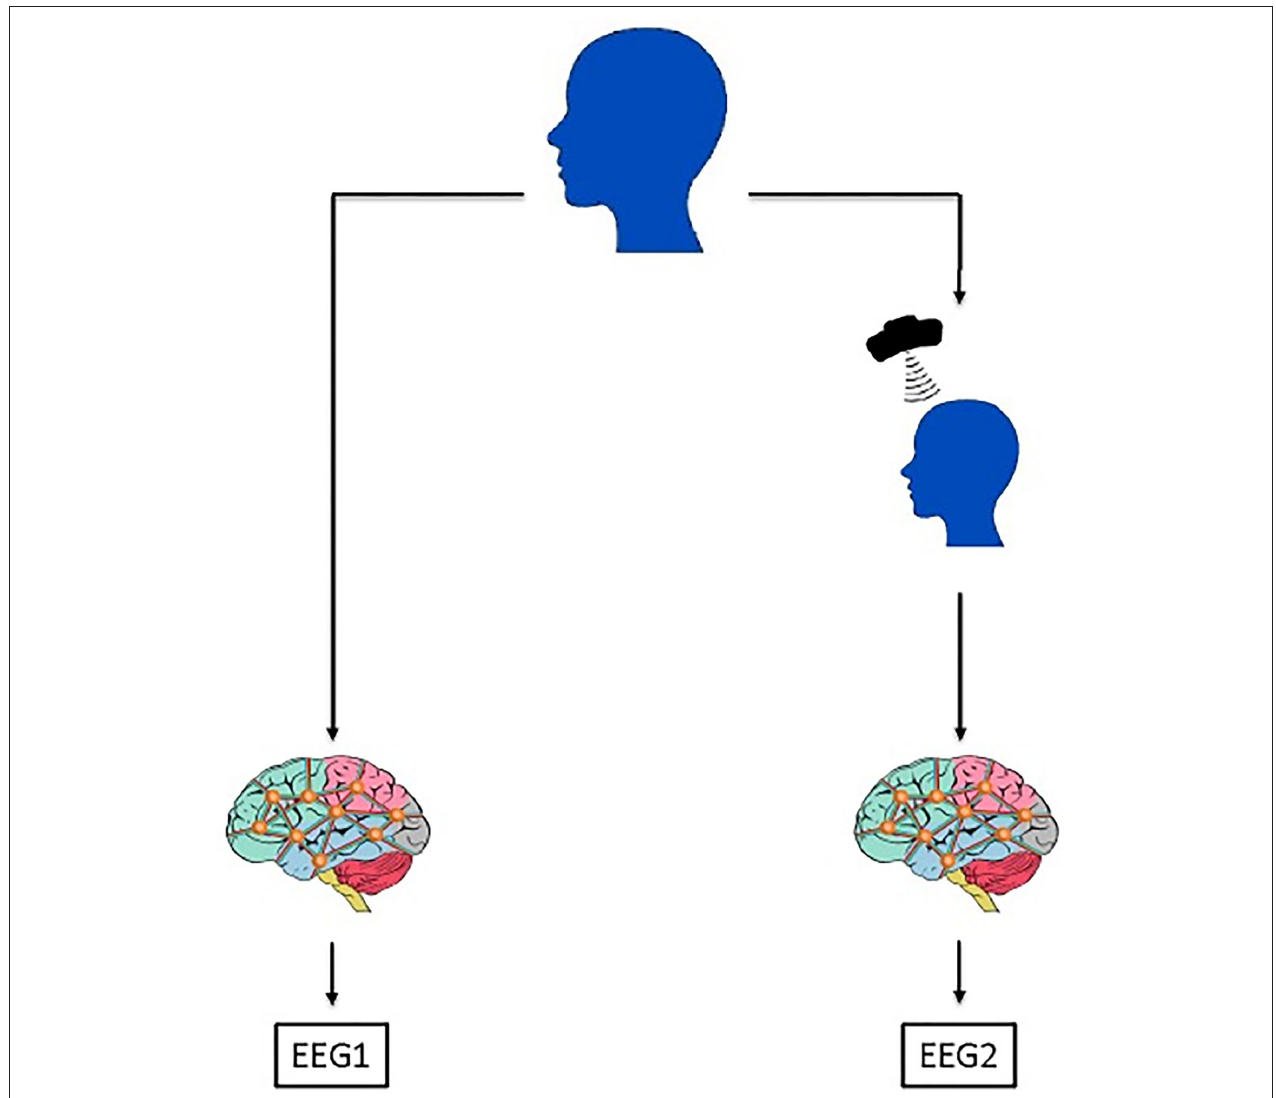
FIGURE 1 | The framework of the data acquisition process. For each patient, EEG signal collection is applied once before the TMS treatment application, that EEG signal is labeled as EEG1 in the manuscript. Another EEG signal is collected after the TMS treatment application which is labeled as EEG2. In this study, EEG1 and EEG2 were separately analyzed. Through the EEG1, we gather the information if it is possible to predict the patients’ response to the treatment. On the other hand, by the analysis of EEG2, we sought for the effects of TMS application on patients’ EEG signal if it is dependent on the patients’ benefit from the